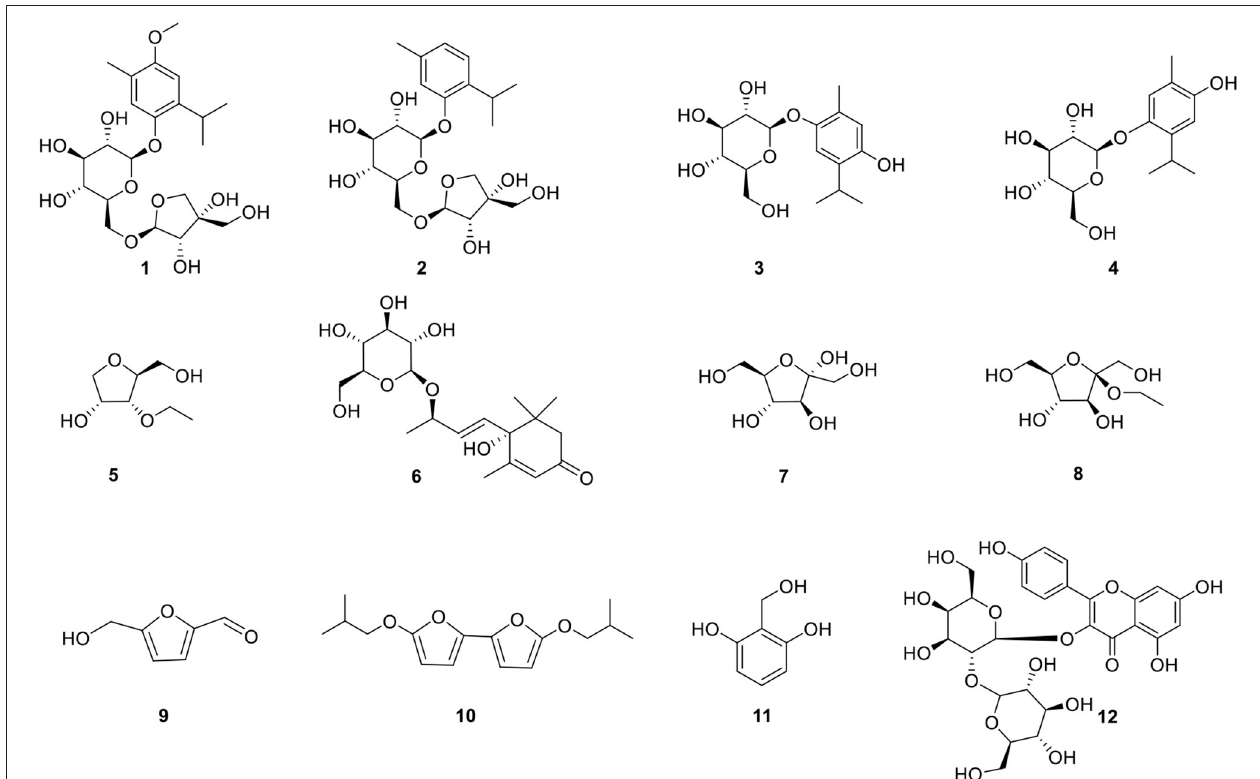
FIGURE 1 | Structures of compounds isolated from N. sativa